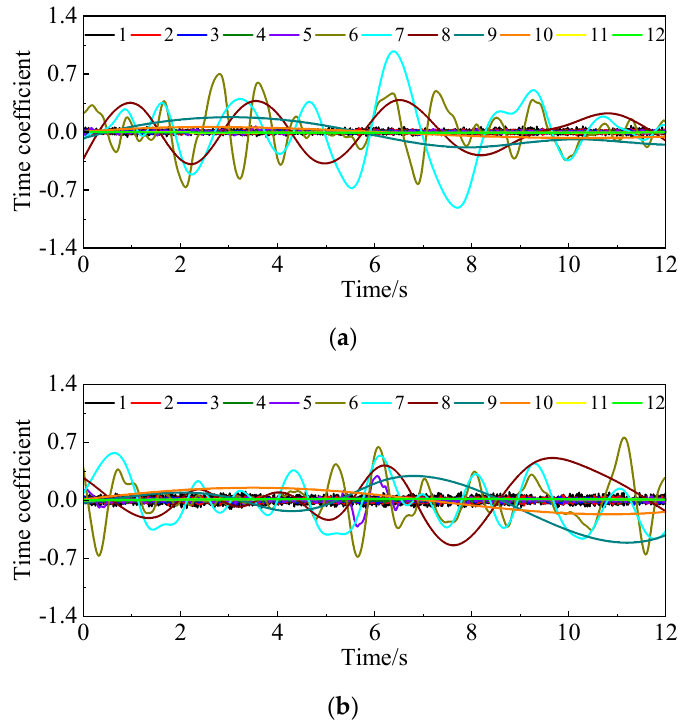
Figure 9. Intrinsic mode function: ( a ) None; ( b ) Control.